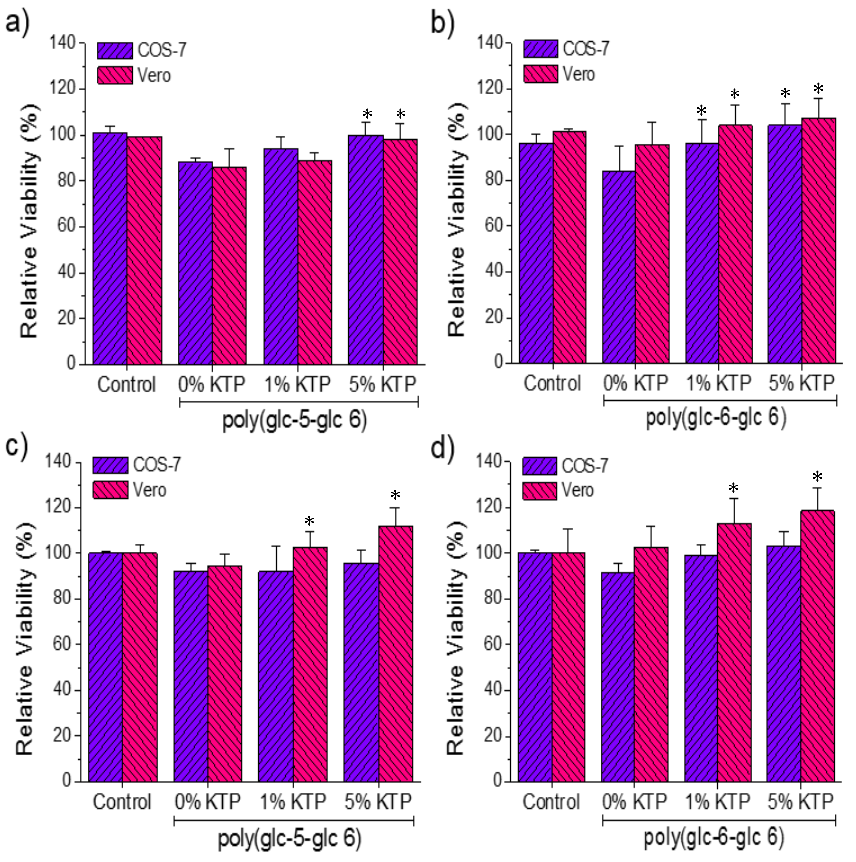
Figure 12. Results of the cellular adhesion ( a , b ) and proliferation ( c , d ) of COS7 and VERO on the surface of poly(glc-5-glc 6) ( a , c ) and poly(glc-6-glc 6) ( b , d ) electrospun scaffolds. * p < 0.05 versus unloaded matrix (0%